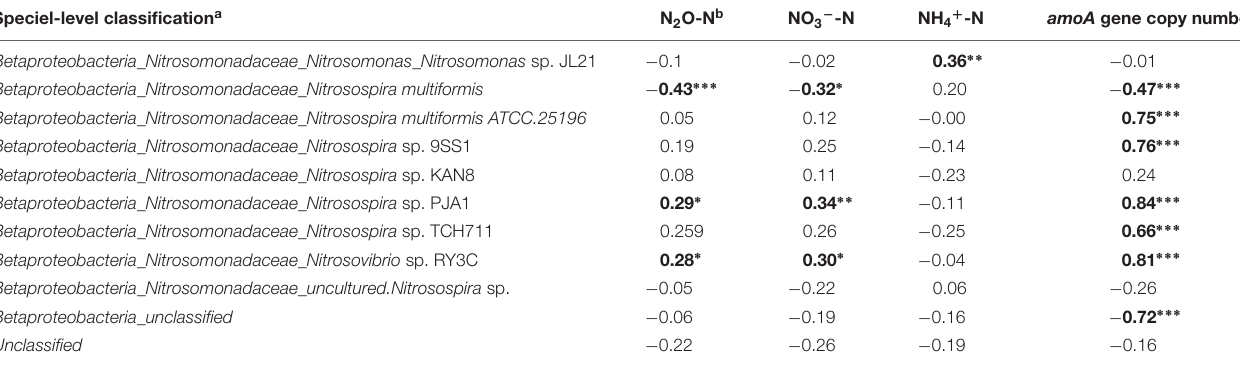
TABLE 3 | Spearman’s correlation coefficients between the amoA OTUs (classified at the species level) and amoA gene copy number (determined by qPCR), N 2 O emission flux and mineral N (NH 4 + -N and NO 3 − -N) values. Speciel-level classification a N 2 O-N